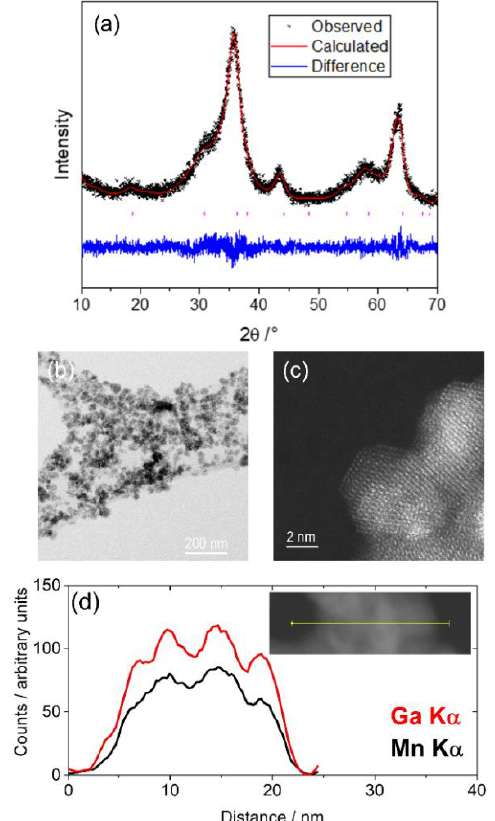
Figure 3. ( a ) Pawley refinement against powder X-ray diffraction of manganese gallium oxide prepared solvothermally; ( b ) and ( c ) TEM images of the material at two different magnifications, and ( d ) EDS line-scans showing the homogeneous distributions of the two metals.